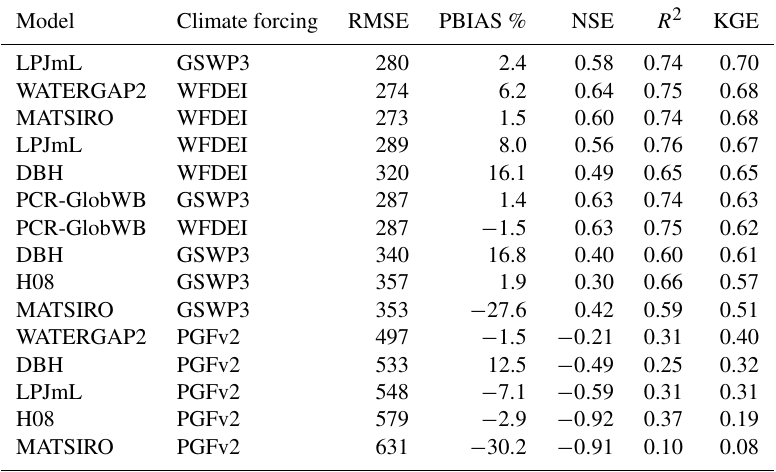
Table A2. The mean goodness-of-fit measures of area-to-line downscaling method for all included GHM–climate forcing pairs. The values are averaged over all 10 monitoring stations.